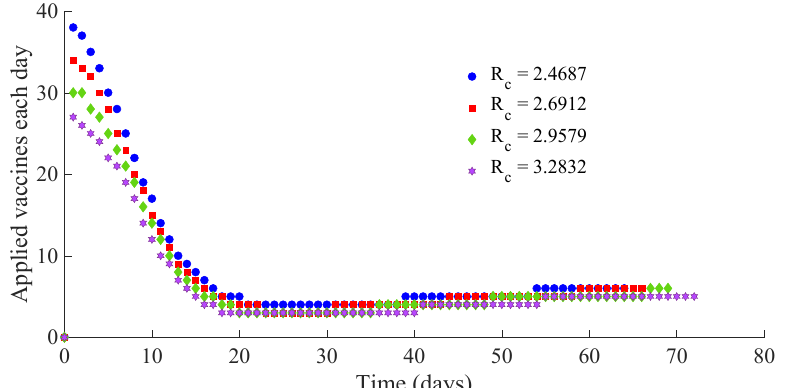
Figure 13. Number of applied vaccines each day for the four considered values of the control parameter c 2 .